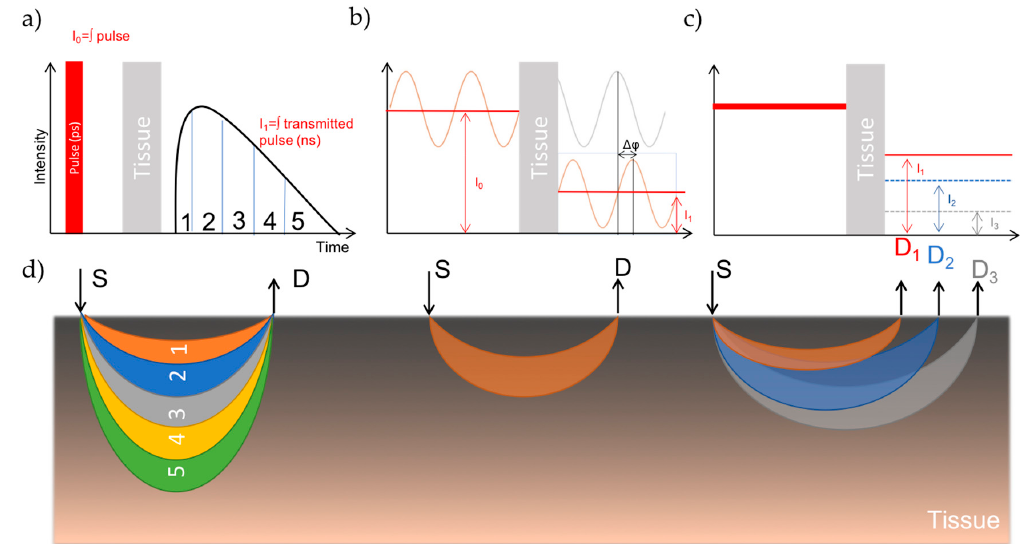
Figure 1. Schematic of the three NIRS detection modes. ( a ) TD-NIRS mode, an ultra-short light impulse is shined onto the tissue and the broadened and attenuated re-emitted pulse is measured after passing through the tissue. ( b ) FD-NIRS, a modulated (MHz) continuous light source is shined onto the tissues and the attenuated, phase shifted reemitted light is measured. ( c ) CW-NIRS, a continuous light is shined onto the tissues and the attenuated re-emitted light is measured. ( d ) Representation of the photon path in tissues for each technique. S: source, D: detector.